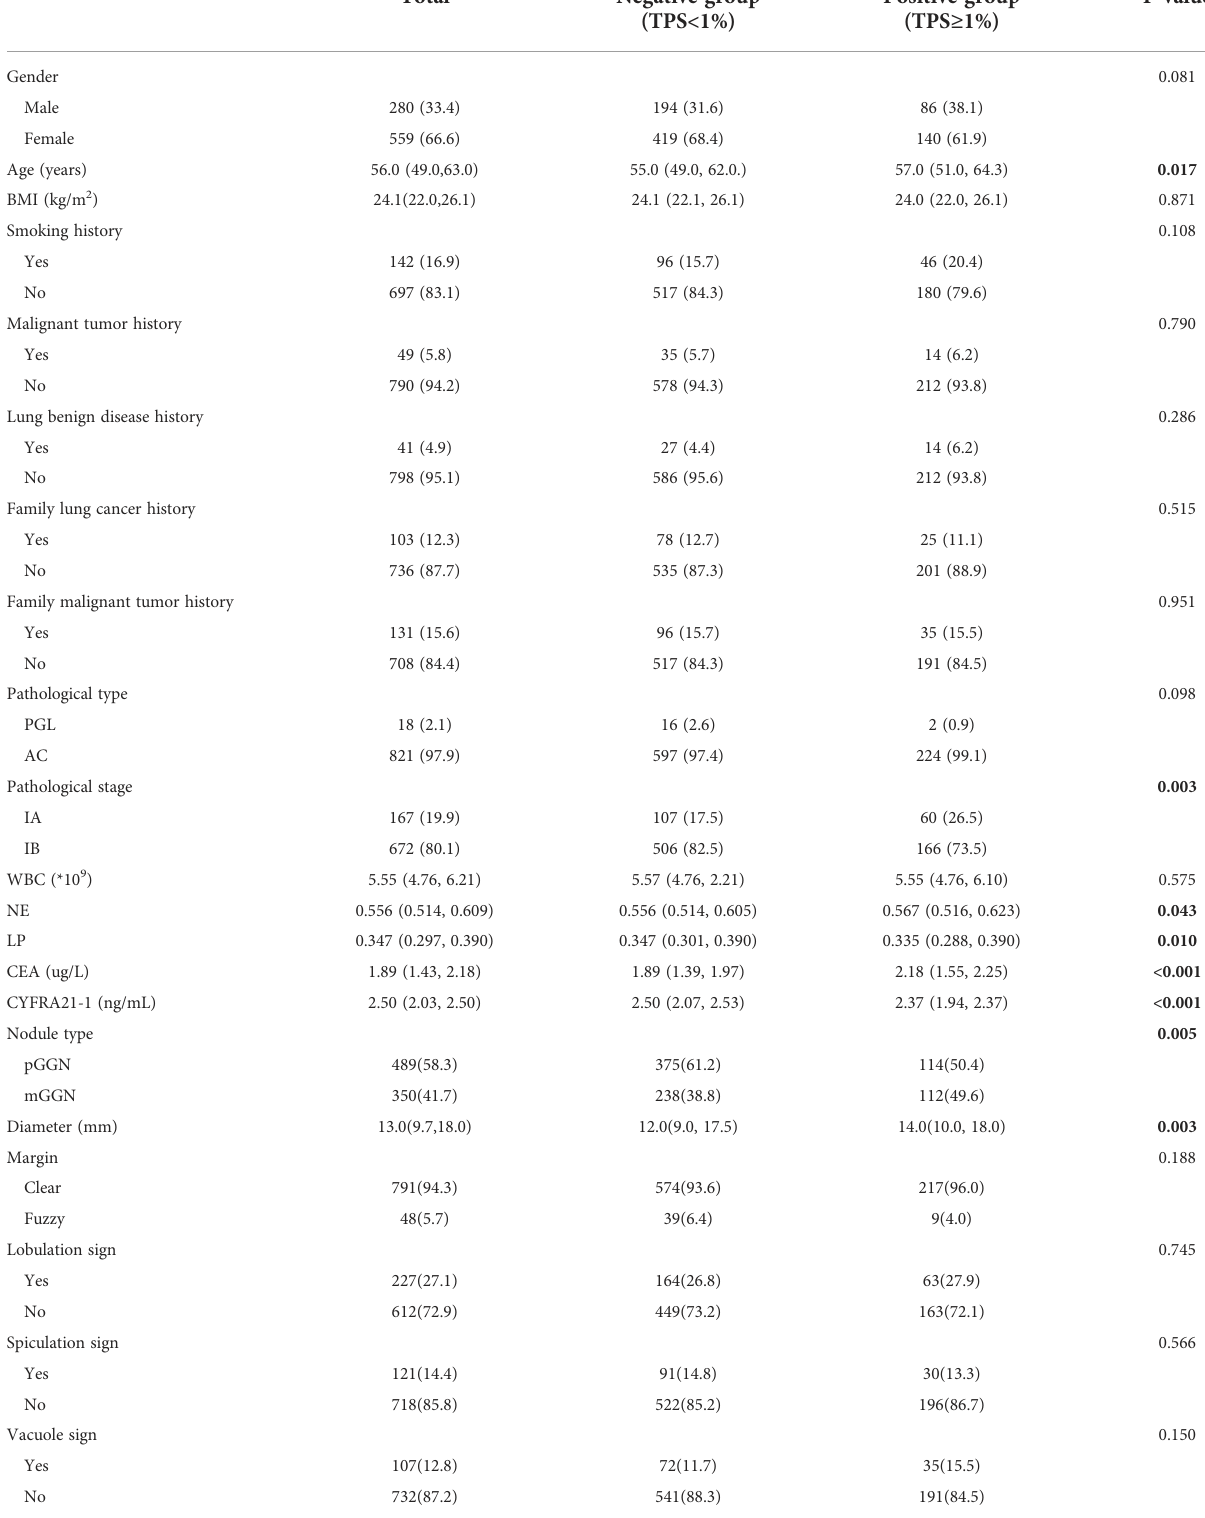
TABLE 1 Comparison of clinicopathologic and CT morphological